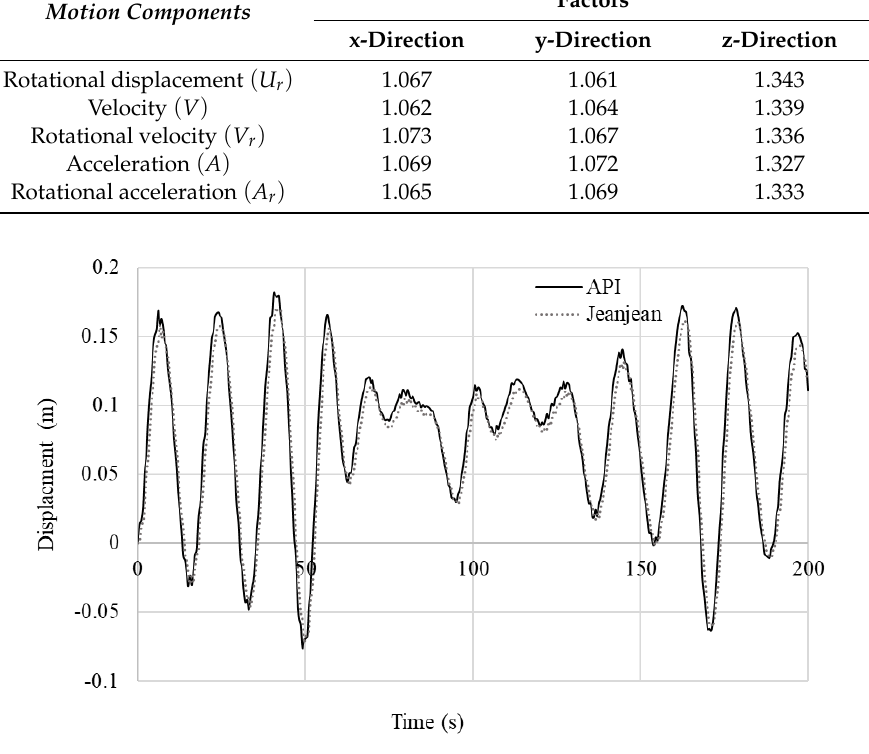
Figure 22. Comparison of the displacements in the x-direction of the jacket foundation resulting from two methods of nonlinear soil stiffness models.